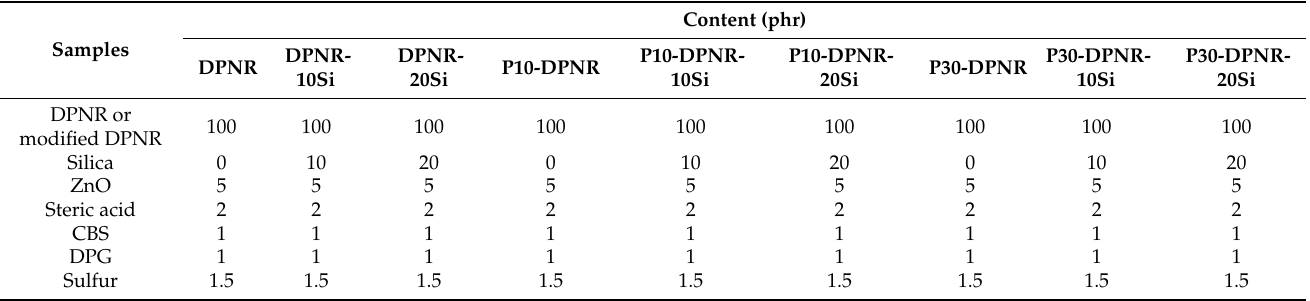
Table 2. Formulations of the silica-filled (PAA- co -PAM)-DPNR